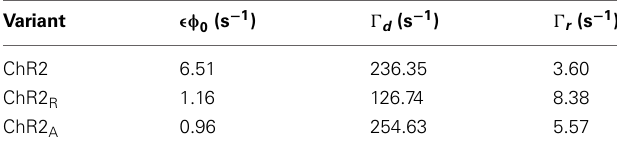
Table 1 | Markov model parameters for each ChR2 variant obtained from fitting the amplitude response function (Equation19) to the empirically derived response function.